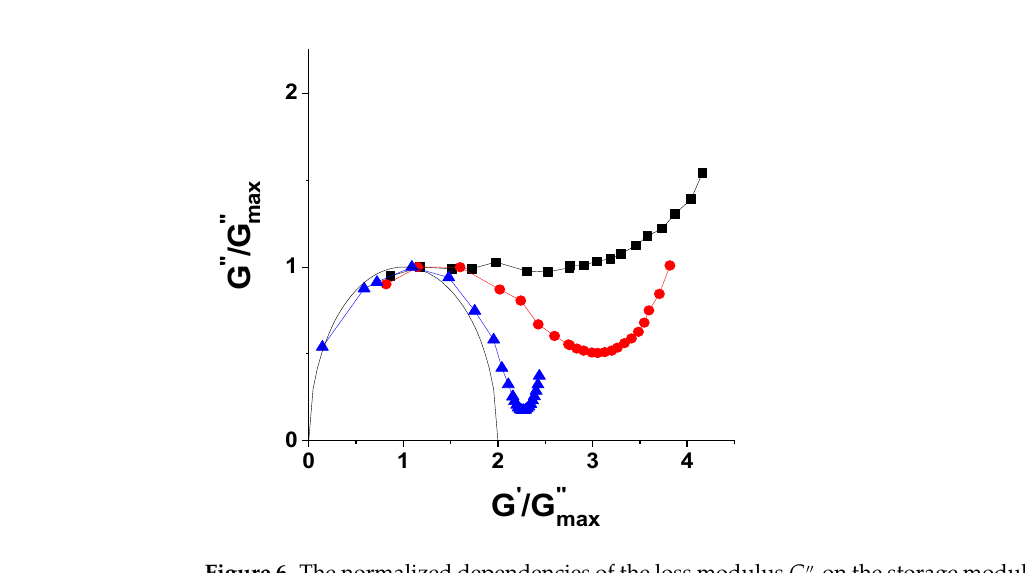
Figure 6. The normalized dependencies of the loss modulus G (cid:48)(cid:48) on the storage modulus G (cid:48) (Cole-Cole plots) for EHAC solutions at different concentrations: 0.3 wt.% (squares), 0.45 wt.% (circles), and 0.6 wt.% (triangles) in the presence of 1.5 wt.% KCl at 25 ◦ C. The line is the semicircle of the ideal Maxwellian viscoelastic fluid.